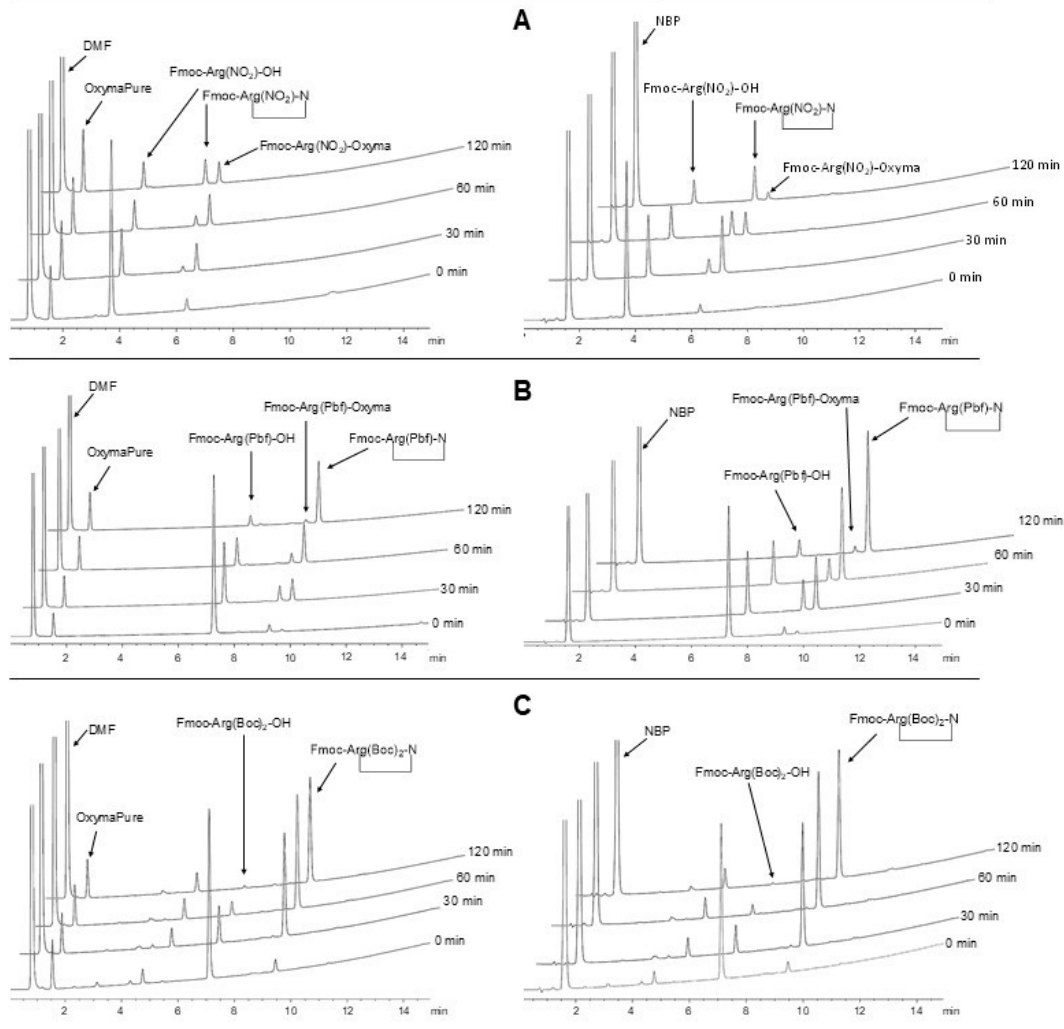
Figure 3. High-performance liquid chromatography (HPLC) chromatograms of the supernatants after the protected Arg derivatives [ A , NO 2 ; B , Pbf; C , (Boc) 2 ] were activated with DIC ( N,N’- diisopropylcarbodiimide) and OxymaPure and then added to the peptidyl resin. Elution: 30–95% of B into A in 15 min.